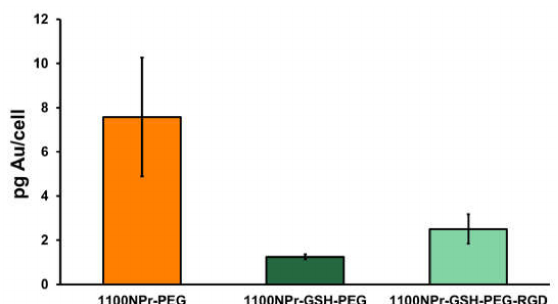
Figure 5. Amount of NPrs internalized by Vero cells after 24 h incubation with 50 µ g / mL NPrs. Gold quantification was measured by inductively coupled plasma mass spectrometry (ICP-MS).